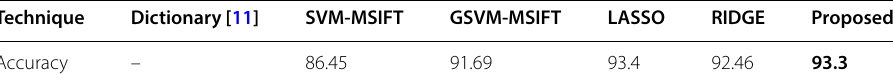
Table 5 Accuracy for different classifiers worked on FGNET database Technique Accuracy